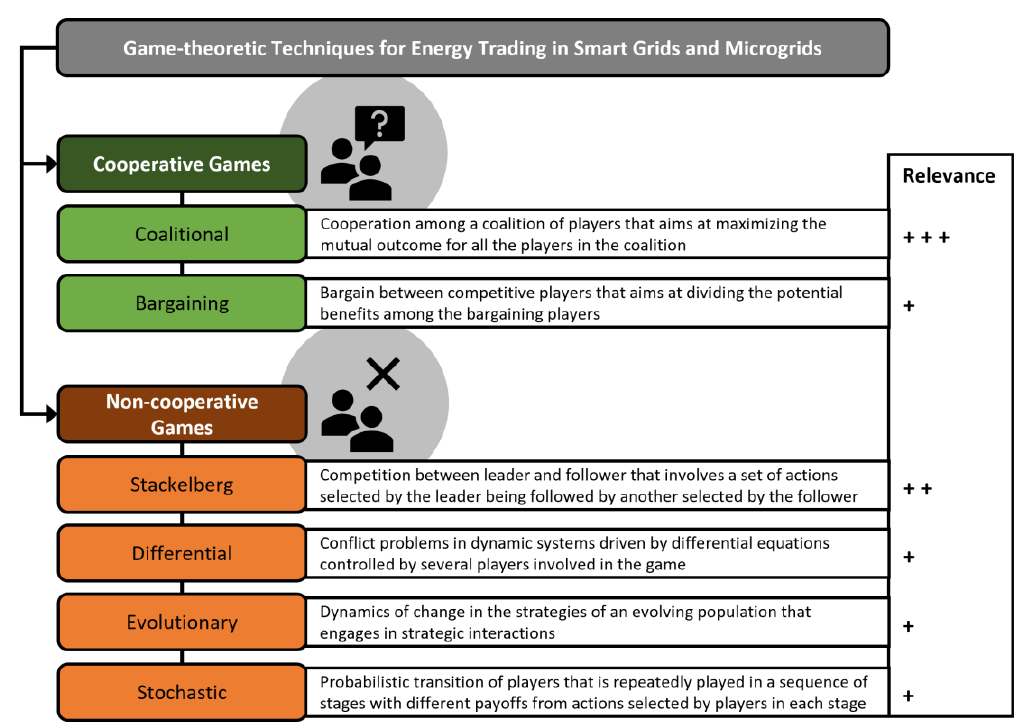
Figure 6. Most common game-theoretic techniques used in the literature for P2P energy trading in SG and MG systems (+ + + = high relevance, + + = medium relevance, + = low